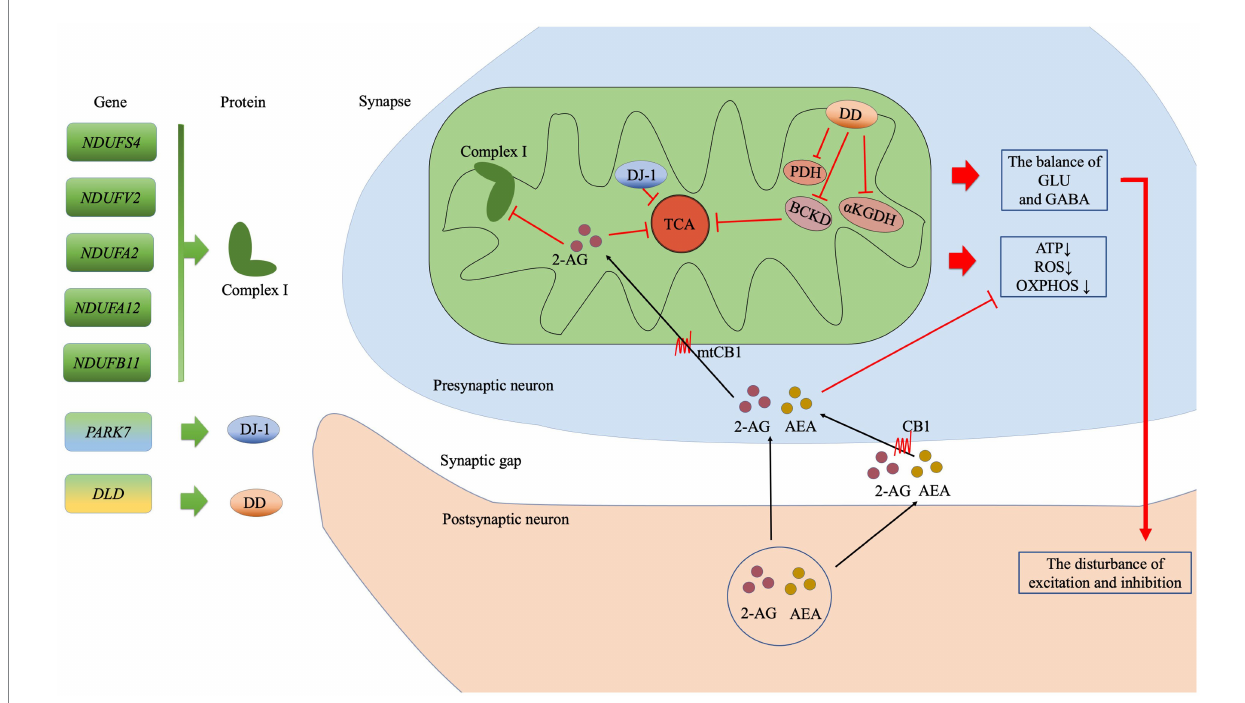
FIGURE 4 The possible mitochondrial mechanisms associated with the top seven genes in the eCB pathway analysis. The subunits of complex I are encoded by NDUFS4 , NDUFV2 , NDUFA2 , NDUFA12 , and NDUFB11 . PARK7 encodes the DJ-7 protein, while DLD encodes dihydrolipoamide dehydrogenase (DD), which in turn affects the enzyme complexes such as BCKD, PDH, and α KGDH. The eCBs 2-arachidonoylglycerol (2-AG) and anandamide (AEA) are synthesized in the postsynaptic membrane on demand. Then, 2-AG may enter the presynaptic membrane via CB or simple diffusion, following which it may inhibit oxidative function by acting on CB1 at the mitochondrial membrane (mtCB1) and regulating the subunits of complex I. Ultimately, the effects of this process on the TCA cycle reduced production of ATP, ROS generation, and reduced OXPHOS. In addition, disturbances in the balance of GLU and GABA exert an effect on synaptic function. Abbreviation: complex I: mitochondrial complex I (NADH: ubiquinone-oxidoreductase); BCKD: branched-chain alpha-keto acid dehydrogenase; PDH: pyruvate dehydrogenase; α KGDH: alpha-ketoglutarate dehydrogenase; TCA: tricarboxylic acid; ATP, adenosine triphosphate; ROS: reactive oxygen species; OXPHOS: oxidative phosphorylation; GLU: glutamate; GABA: γ -aminobutyric acid GABA; 2-AG: 2-Arachidonoylglycerol; AEA: anandamide or N-arachidonoylethanolamine; CB1: cannabinoid receptor 1; mtCB1: cannabinoid receptor 1 expressed on the mitochondrial